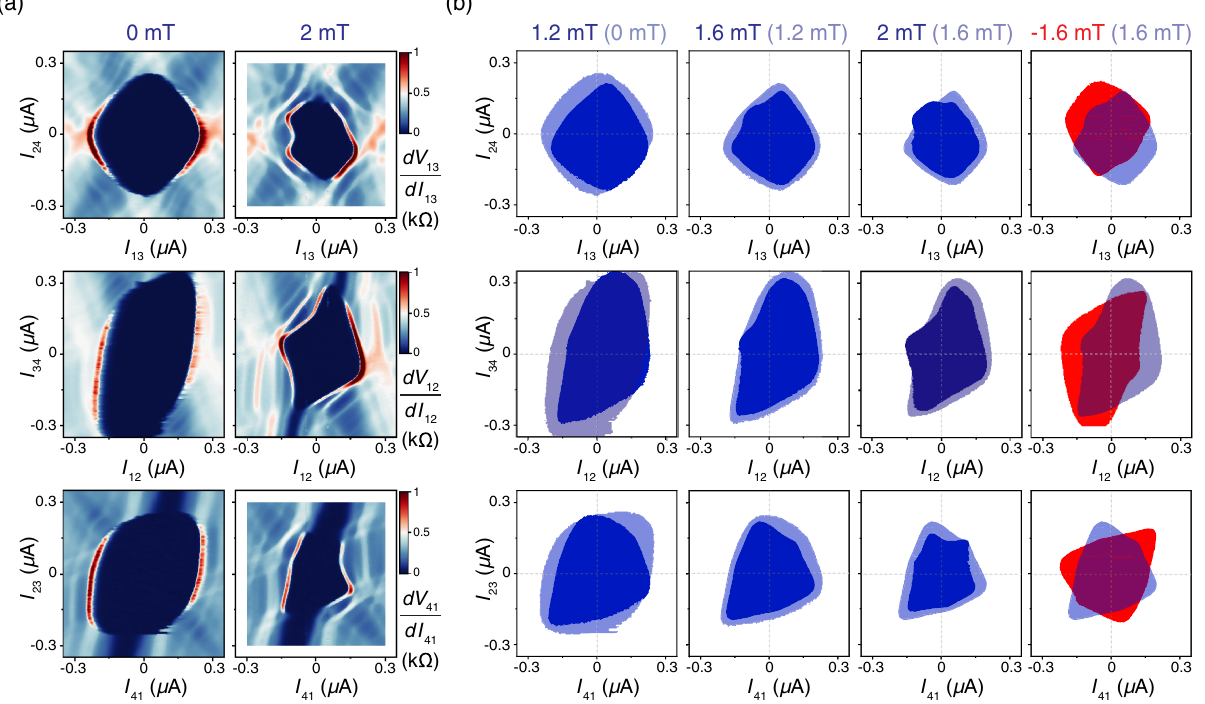
FIG. 4. Effect of magnetic field on a four-terminal junction. (a) Differential resistance maps of a symmetrically biased four-terminal junction measured at B ¼ 0 (left) and B ¼ 2 mT (right). The three rows represent the three symmetric bias current-current planes ð I Þ , ð I Þ , and ð I Þ . The maps of the resistance of the complementary terminal pairs (2,4), (3,4), and (2,3) are not shown. 13 ; I 24 12 ; I 34 41 ; I 23 (b) Evolution of CCC in a magnetic field. The extracted zero-voltage regions, which the CCCs surround, are depicted by a color. Note the comparison of data at B ¼ 1 . 6 mT (transparent blue) versus B ¼ − 1 . 6 mT (transparent red), which is equivalent to inversion of the CCC around the